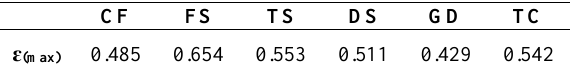
Table 1. ɛ max values (g C·MJ -1 ) used for given biomes (CF: coniferous forest, FS: forest steppe, TS: typical steppe, DS: desert steppe, GD: gobi desert, TC: tundra & cushion).